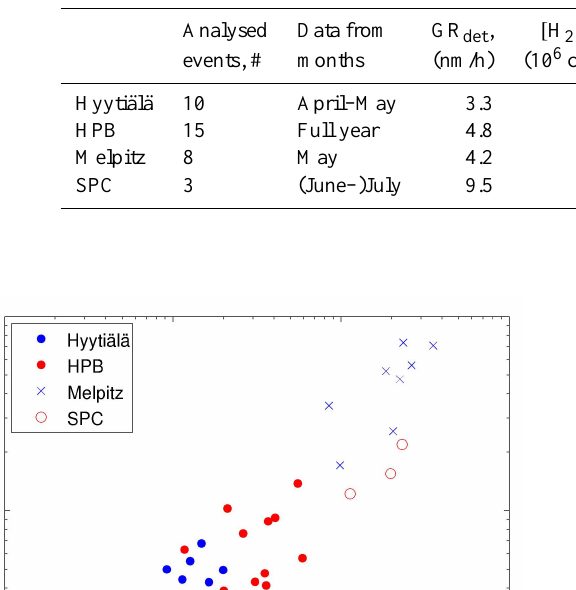
Table 1. Statistics of the new particle formation events at different measurement sites. The observed growth rates GR det are median values for all the events. The tabulated median values for sulphuric acid concentration [ H 2 SO 4 ] , low-volatility organic vapour concentration [ org ] , neutral particle formation rate J 2 and ion formation rate J ion the nucleation events.